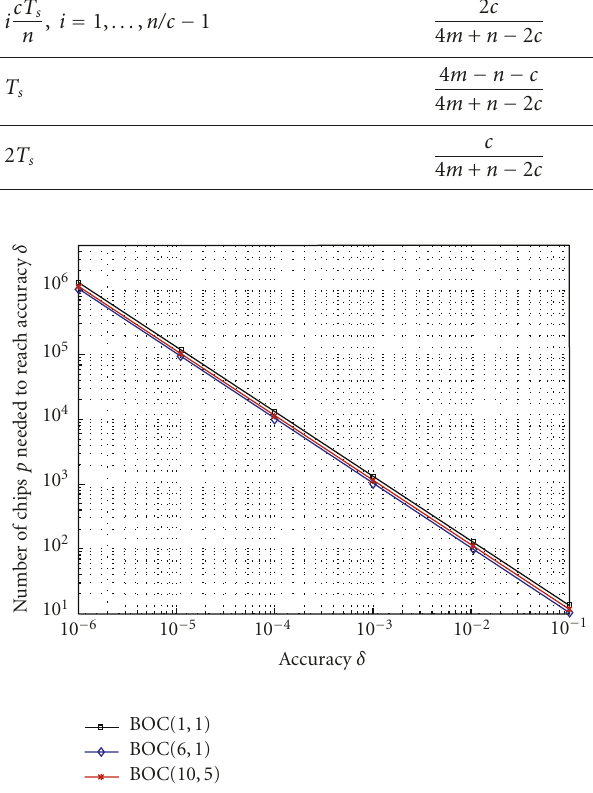
Table 2: BOC( m , n ) run length statistics with c = gcd(2 m , n ). Run length Fraction in distribution